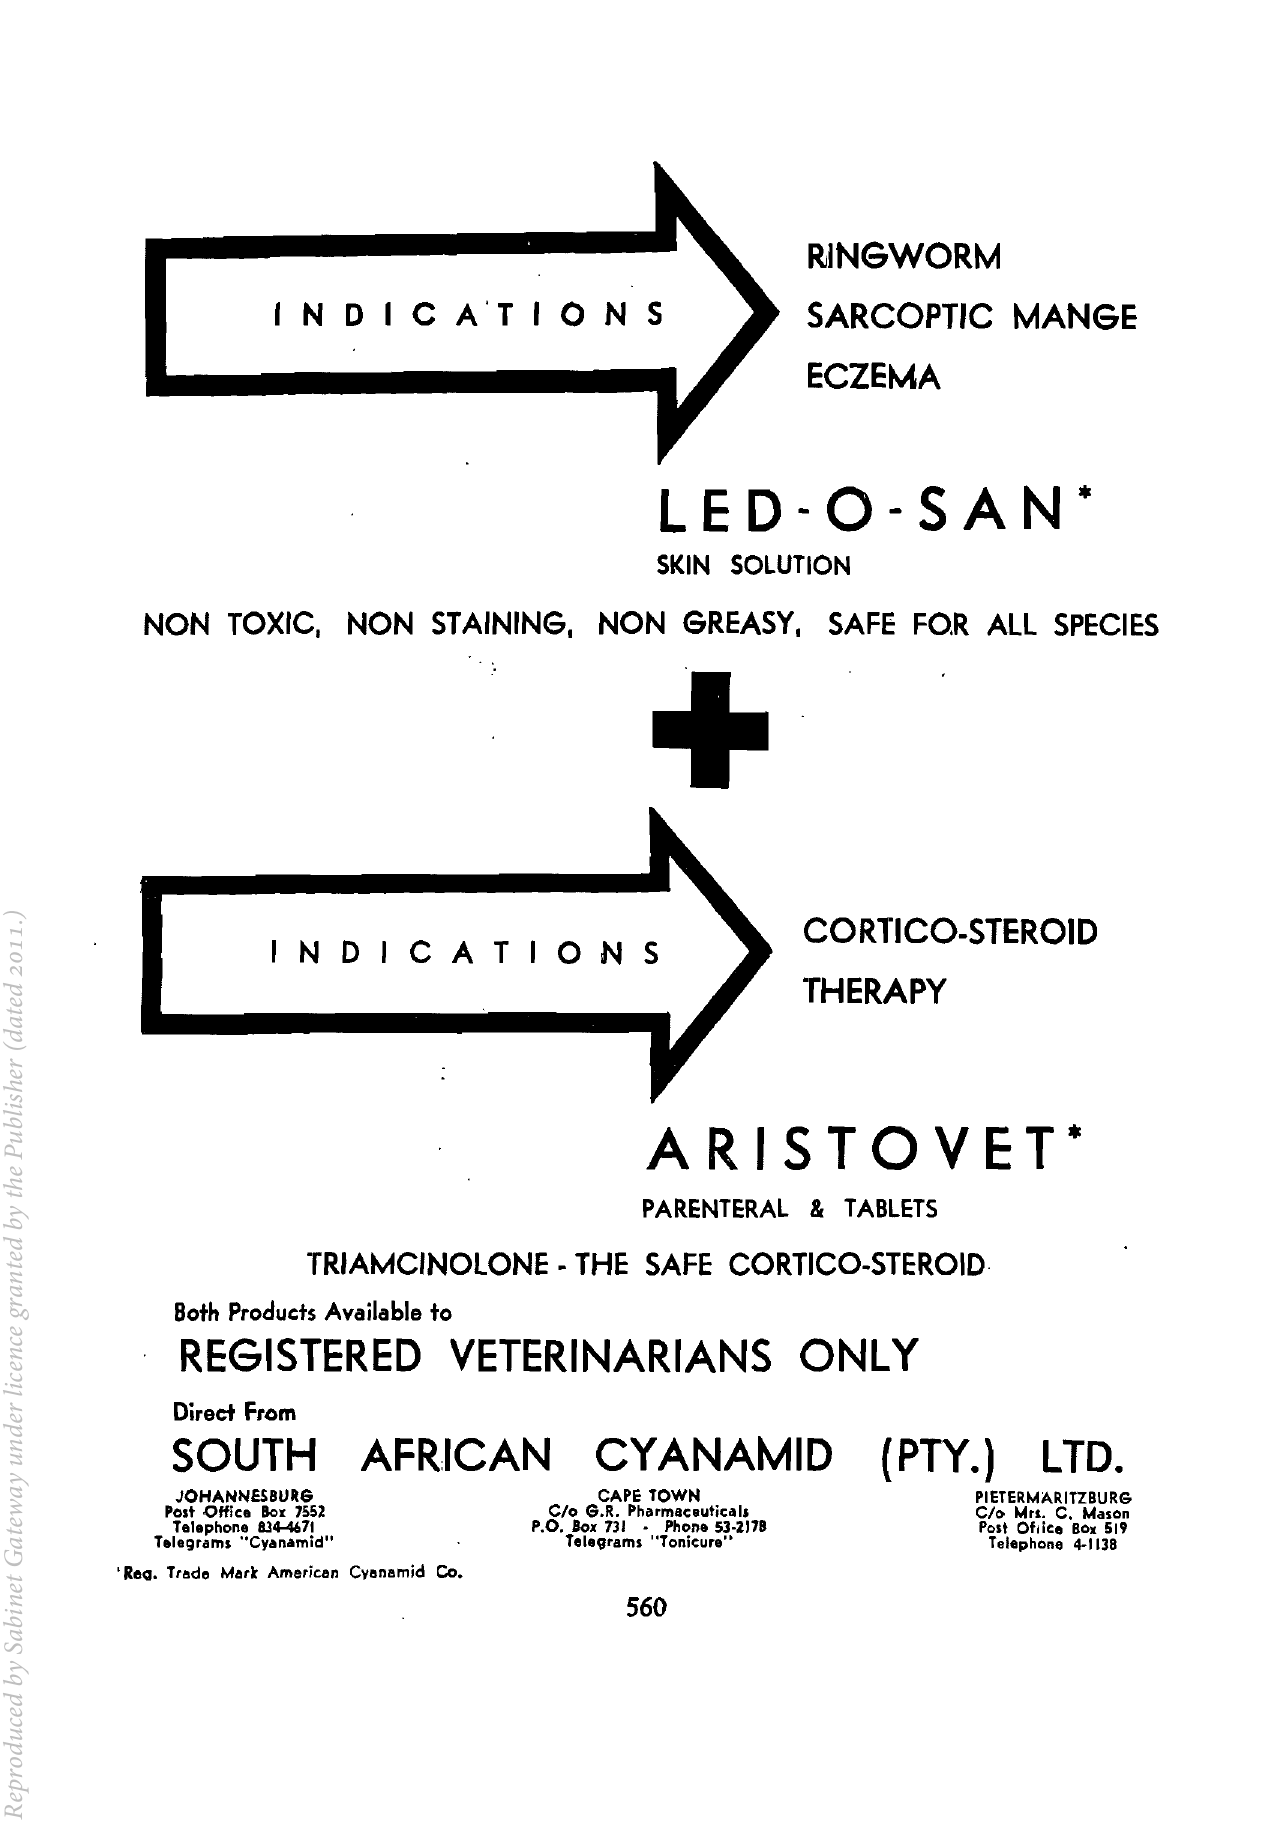
NON TOXIC, NON 5T